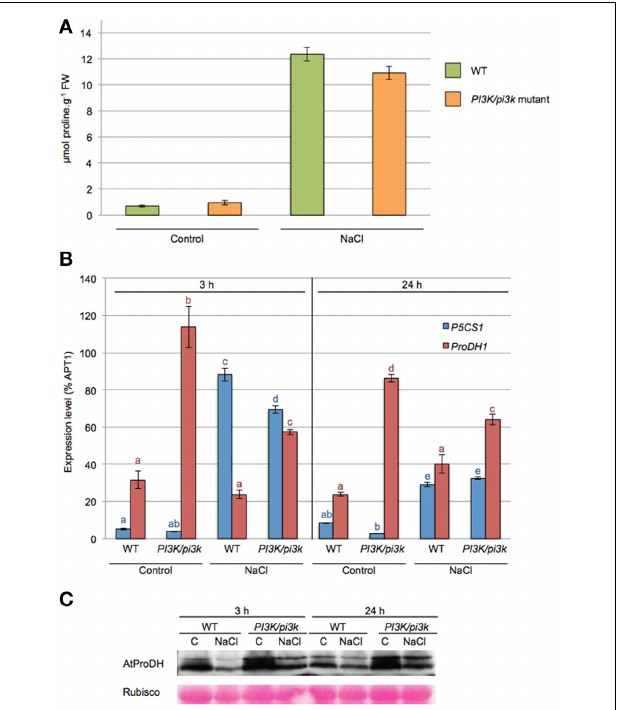
FIGURE 5 | ProDH1 transcript and protein levels are affected in pi3k hemizygous mutant. Twelve-days-old WT and pi3k hemizygous mutant ( PI3K/pi3k ) seedlings were stressed with 200mM NaCl (NaCl) or maintained in 0.5 × MS (control, C) during 3h or 24h. (A) Proline levels were measured in 24h-stressed seedlings. Results shown are means ± SD of 6 to 10 biological repetitions in two independent experiments. FW, Fresh Weight. (B) Expression levels of P5CS1 and ProDH1 genes by RT-qPCR on cDNA obtained from 3h to 24 h- treated WT and pi3k hemizygous mutant seedlings. Results expressed as percentage compared to APT1 as a reference gene are means ± SD ( n = 3). Letters indicate statistical differences in P5CS1 (blue letter) or ProDH1 (red letter) gene expression in WT and pi3k hemizygous mutant depending on treatment conditions (Two-Way ANOVA test, P < 0 . 05). (C) Total proteins obtained from 3h to 24 h-stressed WT and pi3k hemizygous mutant seedlings were separated by SDS-PAGE. Western blots were incubated with specific antibodies directed against AtProDH proteins. Detection of the immunolabelled proteins was done by autoradiography using an ECL + kit. Membranes were stained with Ponceau Red as control for protein loading